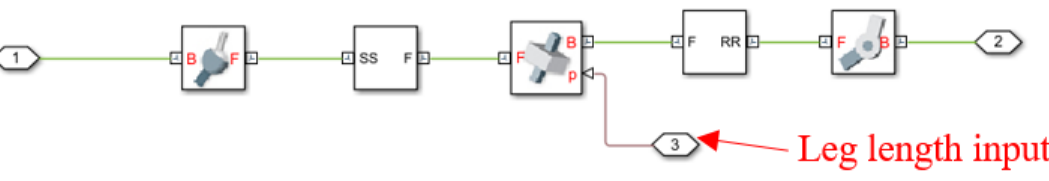
Figure 22. Subsystem diagram under the leg section mask is composed of a spherical joint, a prismatic joint and a revolute joint. Using the prismatic joint as the actuator, and the spherical joint and revolute joint are respectively connected to the S-deck and the R-deck. The direction of different legs is determined by rigid transform module under the R-deck system.